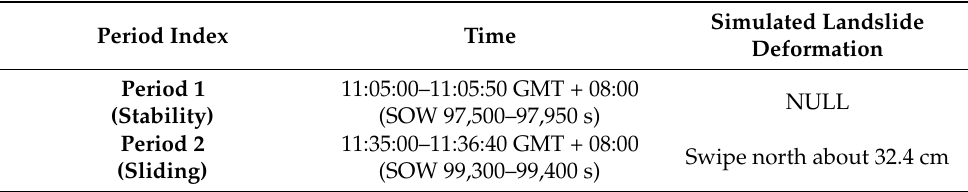
Table 8. Simulation record of landslide deformation in Scene 3.